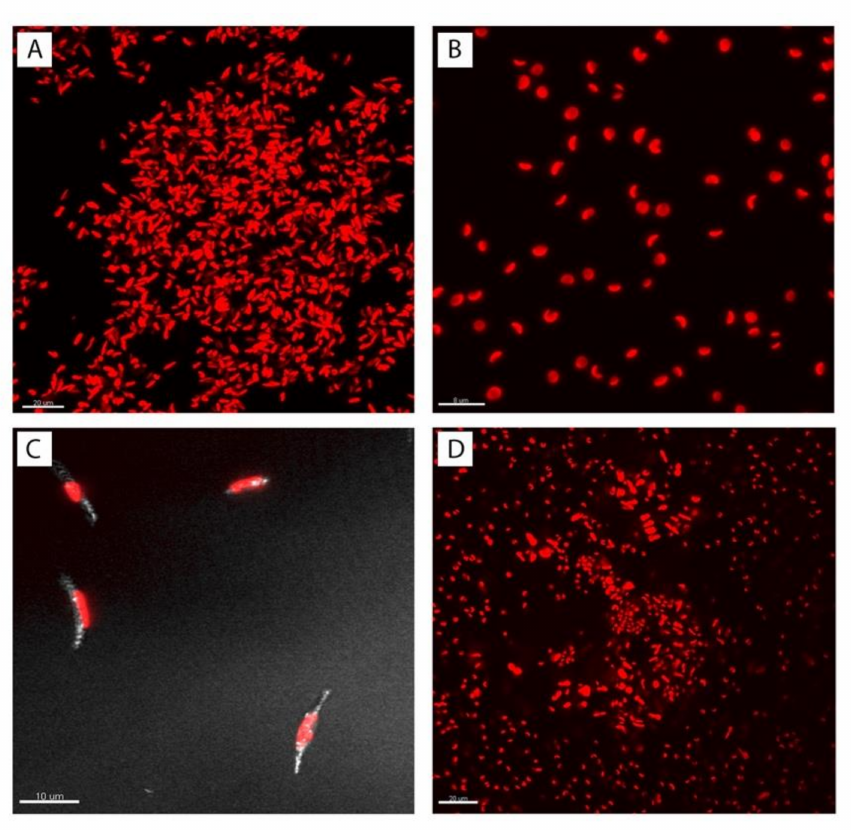
Figure 1. CLSM micrographs of the different cultures, red signal is due to chlorophyll a emission (red channel), white signal to silica cell wall autofluorescence. ( A ). Phaeodactylum tricornutum culture; ( B ). Contaminant culture; ( C ). Details of P. tricornutum fusiform, silica cell walls, white signal; ( D ). Mix co-culture of P. tricornutum and Contaminant